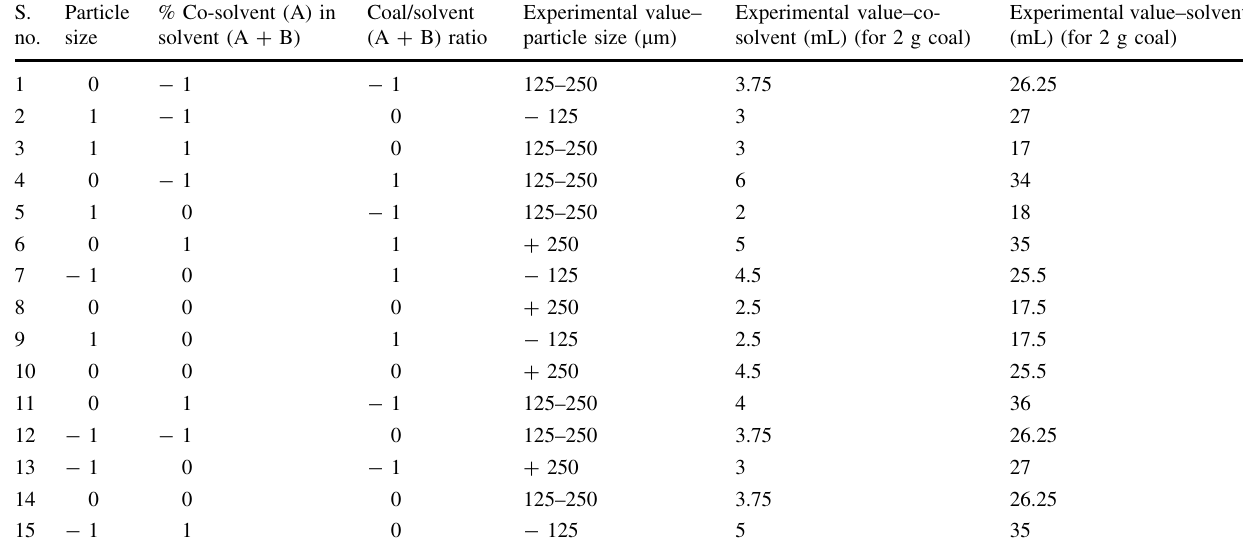
Table 6 15 Runs experimental set up obtained using response surface methodology-Box Behnken design S. Particle no. size